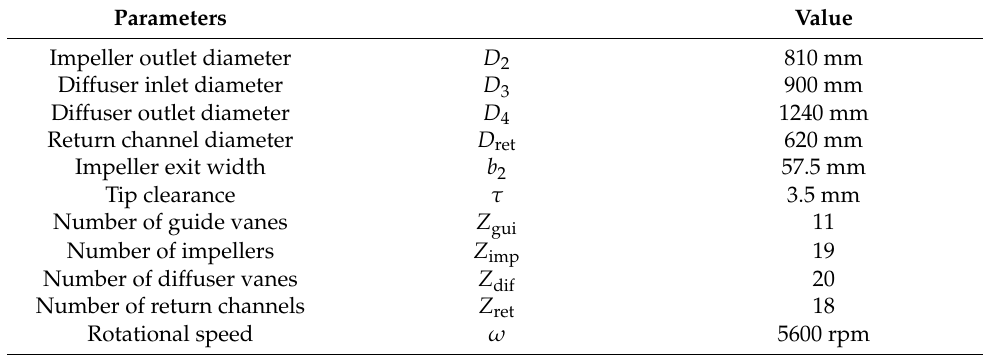
Table 1. Primary geometric parameters of the centrifugal compressor stage.